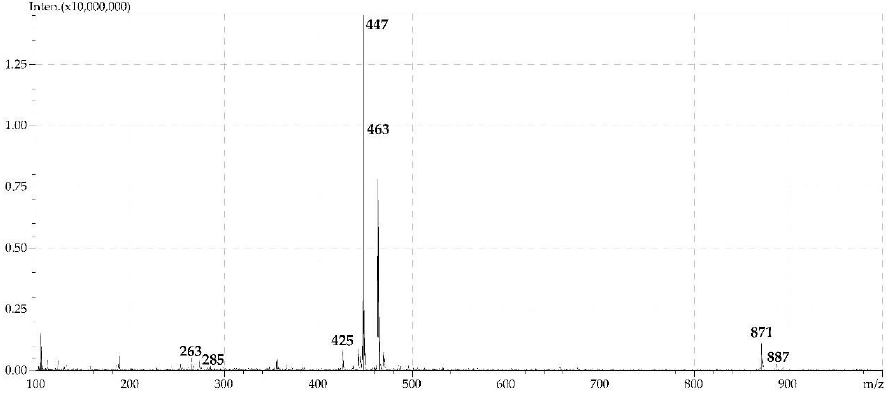
Figure 6. ESI-MS spectrum (positive ionization) of khellactone- 3′ - O -glucoside (praeroside II, 31 ).